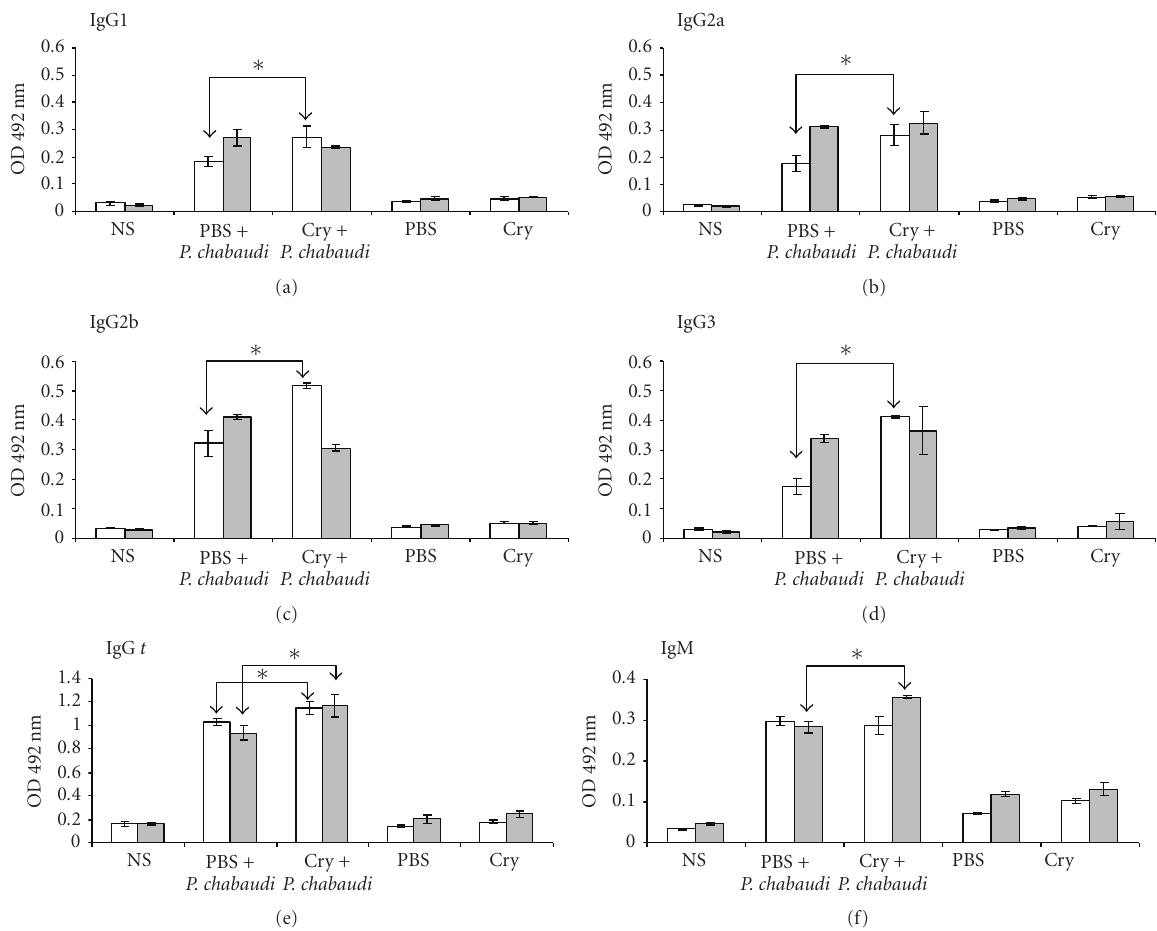
Figure 6: Parasite-specific antibody responses in mice treated with Cry1Ac and infected with P. chabaudi AS. Mice were treated with Cry1Ac protoxin or PBS as described previously and were infected with P. chabaudi AS. At days 8 (white bars) and 18 (grey bars) PI, the sera of three mice from each group were collected and measured by ELISA for antibody levels. The results are expressed as the mean OD value ± SD ( n = 3) . Control absorbance values were provided by normal mouse serum (NS) obtained from age- and sex-matched CBA/Ca mice. Data are representative of two separate experiments. Asterisks indicate statistically significant di ff erences between the indicated